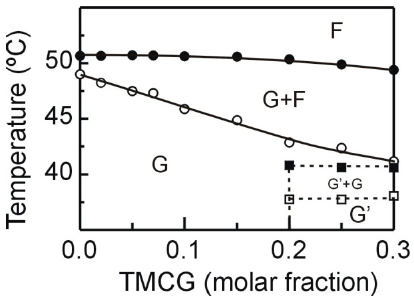
Figure 5. Partial phase diagrams for DMPE in DMPE/TMCG mixtures. Open and solid circles were obtained from the onset and completion temperatures of the gel to liquid crystalline phase transition. The phase designations are as follows: G, gel phase; F, liquid crystalline phase; and G ′ , immiscible gel phase.